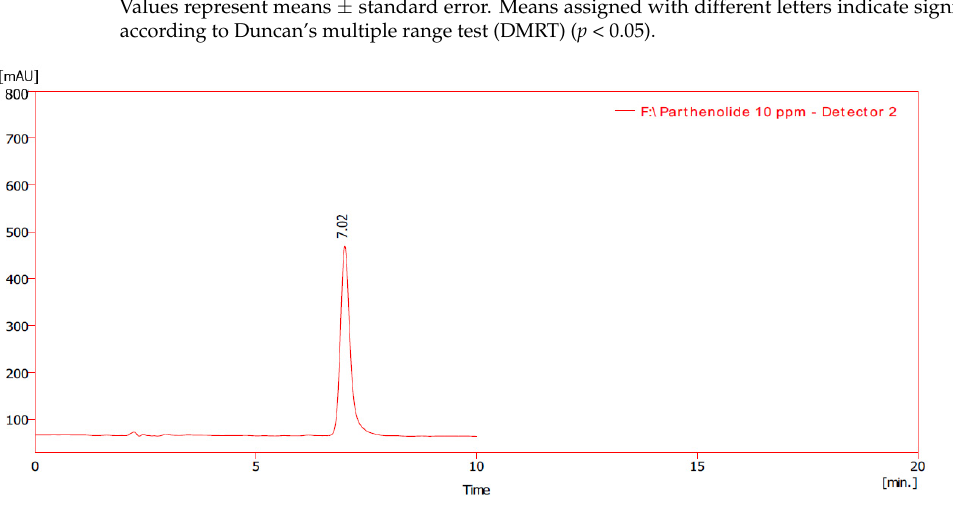
Figure 1. HPLC analysis of parthenolide standard for 10 ppm at 210 nm, flow rate 1 mL/min.